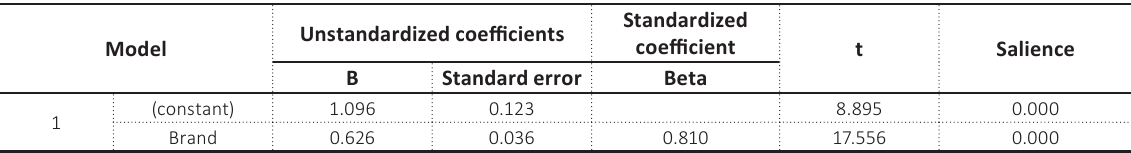
Table 6. Linear regression coefficients of the relationship between brand image and consumers’ purchase intention